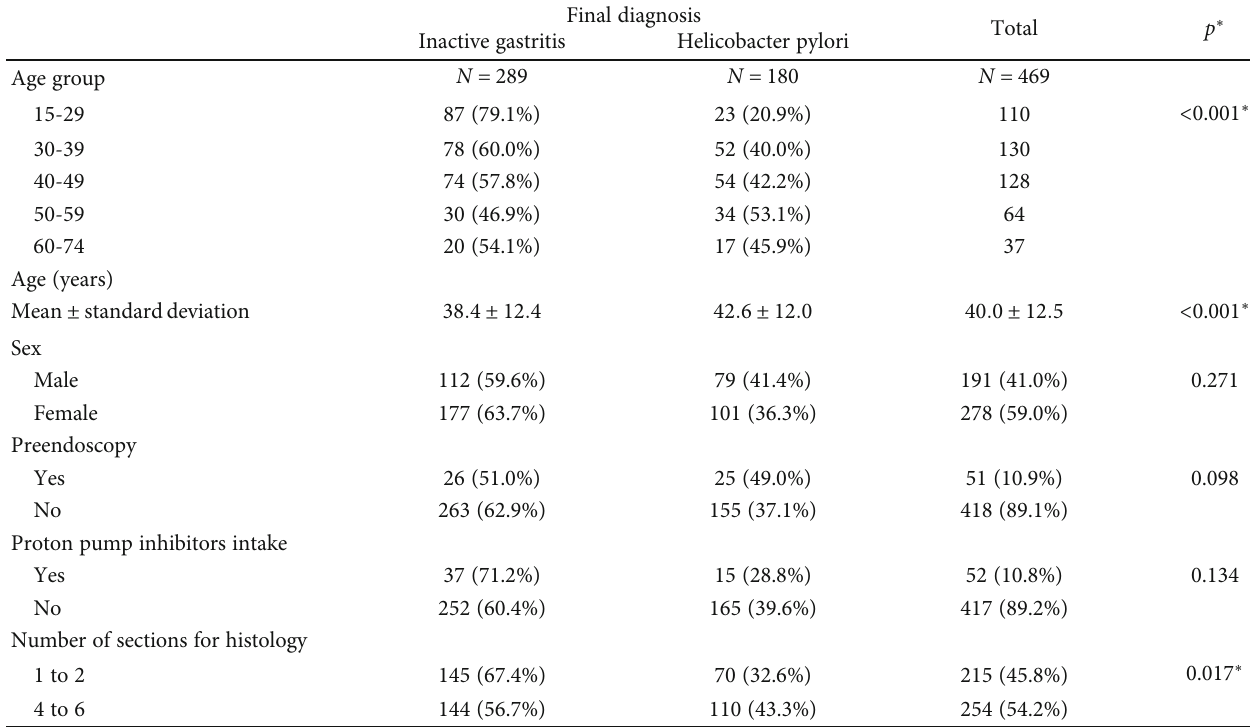
Table 2: Patient characteristics by histopathologic fi